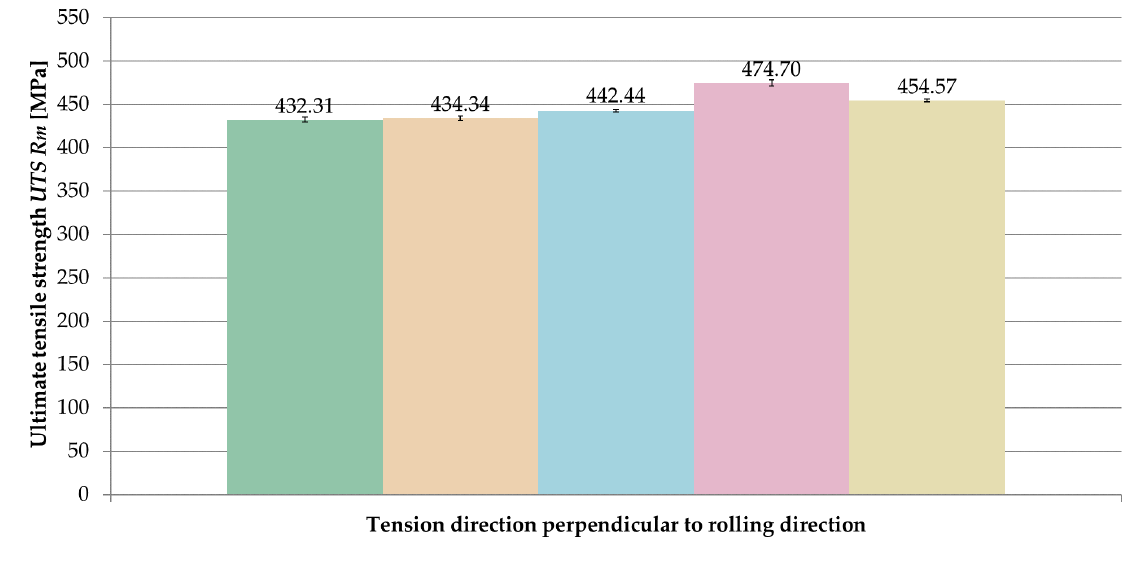
Figure 9. Comparison of ultimate tensile strength UTS R m for samples stretched perpendicular to the rolling